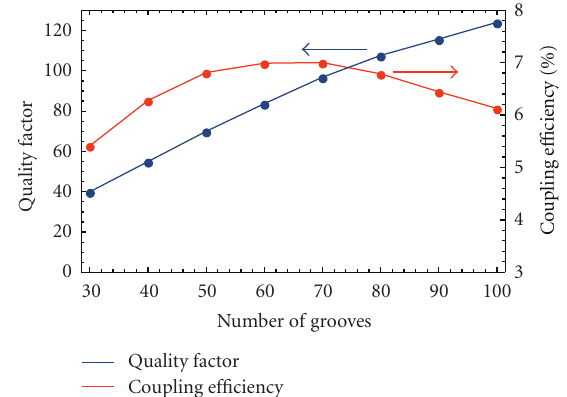
Figure 3: Comparison of coupling e ffi ciency and quality factor as a function of number of grooves. Parameters used: t Ge = 1 . 65 μ m, t = 200nm, t = 200nm, d G = 100nm, Λ G = 3 . 14 μ ZnSe,2 Al